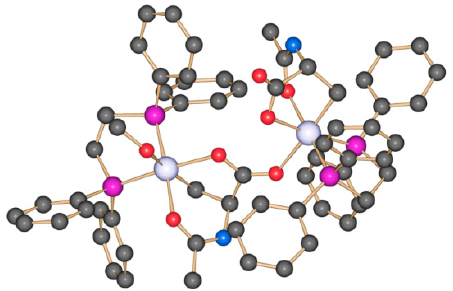
Figure 24. Solid state structure of the dimeric Rh(III)–alkyl complex arising from the reaction of 2- acetamidoacrylic acid with [Rh(DPPE)(MeOH) 2 ]BF 4 , left. Hydrogen atoms are omitted for clarity.